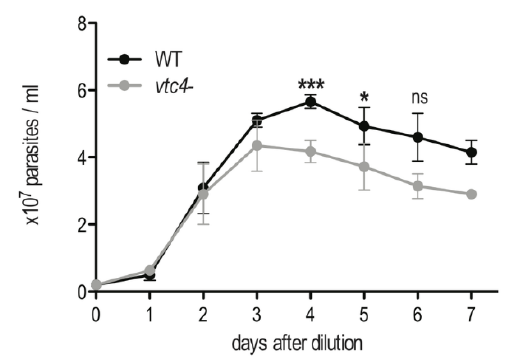
FIGURE 4: In vitro proliferation of VTC4 knockout L. major parasites. L. major WT or vtc4 - promastigotes were diluted at a concentration of 5 x 10 5 parasites per ml and cultured in complete medium. Cell concentrations were counted in independent cultures. Results of a pool of 4 independent experiments were ex- Student’s t-test ; * p < 0.05, *** p < 0.01, ns: